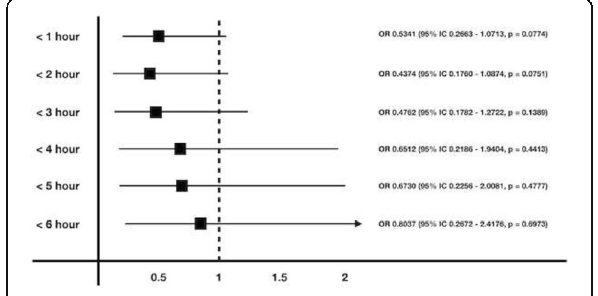
Fig. 3 (abstract 0260). Risk of developing septic shock during the following 30 days per hour of